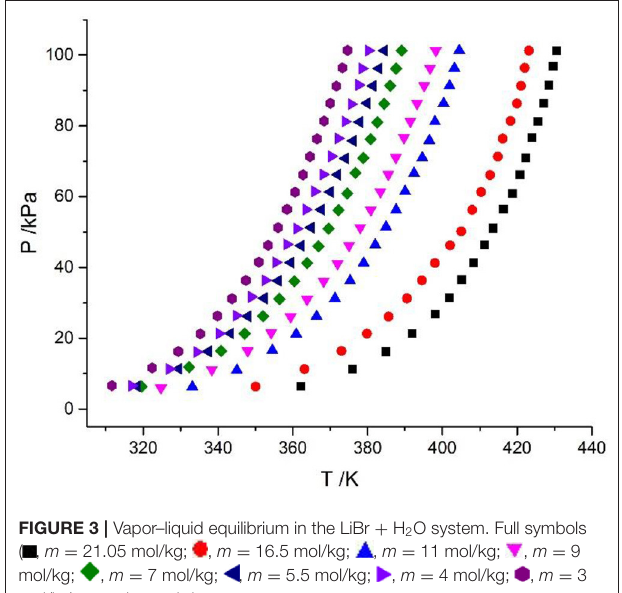
correlate and predict the VLE for the LiBr + H 2 O and LiBr + CaCl 2 + H 2 O systems. The applicable system of the model was extended in this work. The correlation and prediction results were used to compare the Pitzer model (Pitzer, 1973),